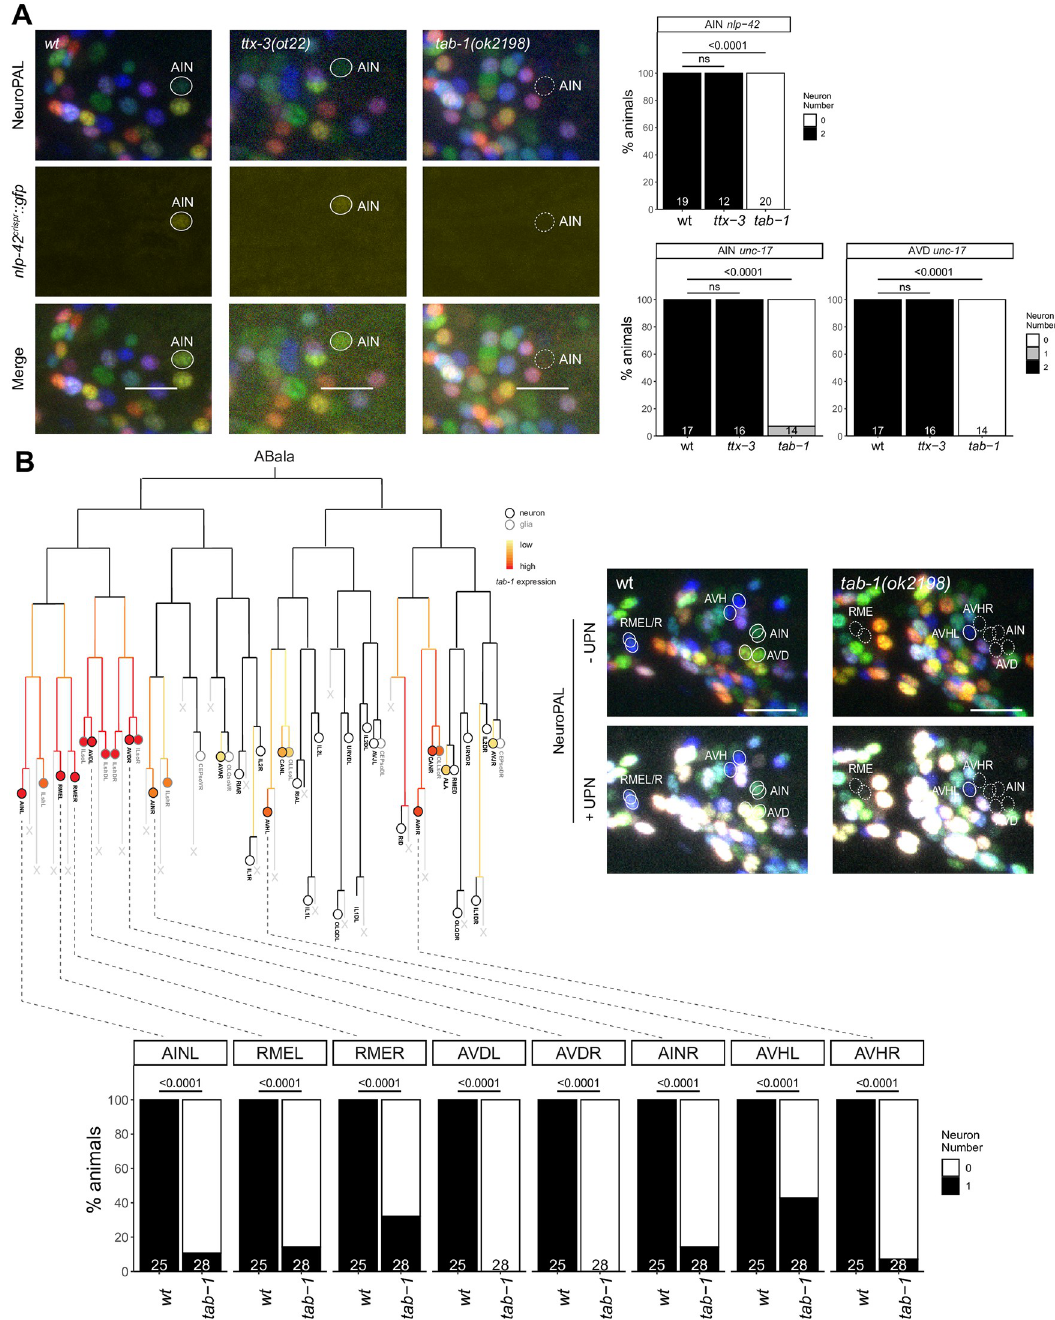
Fig 7. tab-1 regulates the differentiation of various neurons in the ABala lineage. Fig 7A: In tab-1(ok2198) mutants, expression of both nlp-42(syb3238) and NeuroPAL reporters in AIN is lost. tab-1(ok2198) mutants also showed defects in unc-17(otIs576) reporter expression in AIN and AVD. No loss of reporter expression was observed in ttx-3(ot22) mutants. Representative images of wild type and mutant worms are shown with 10 μ m scale bars. Fig 7B: tab-1 is expressed in various neurons derived from the ABala lineage (adapted from Ma et al., 2021). In tab-1(ok2198) mutants, defects in NeuroPAL reporter expression, including ultrapanneuronal (UPN) reporter expression, are seen in neurons which express tab-1 embryonically. Representative images of wild type and mutant worms are shown with 10 μ m scale bars. In all panels, neurons of interest are outlined in solid white when expressing wildtype reporter colors, and dashed white when one or all colors are lost. P-values were calculated by Fisher’s exact test.